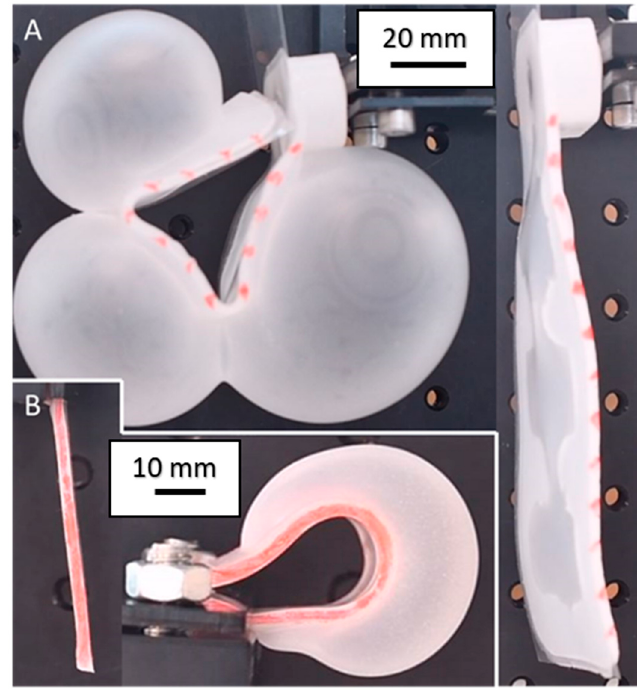
Figure 10. ( A ) Large actuator fabricated using Approach 1 in an inflated and deflated state. ( B ) Actuator fabricated using Approach 2 in an inflated and deflated state.